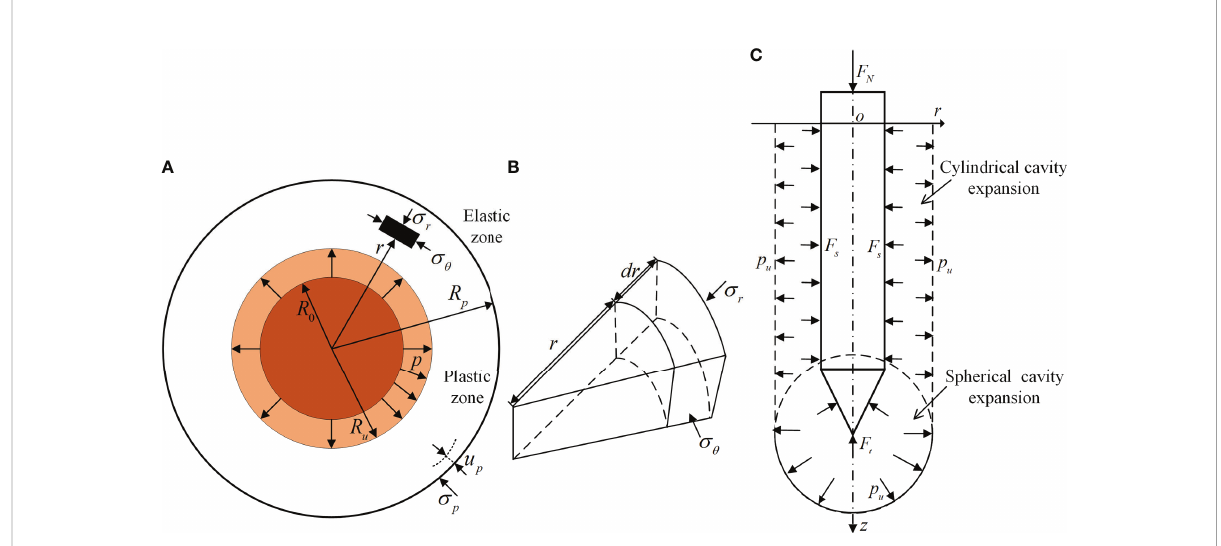
FIGURE 3 (A) Cylindrical cavity expansion model diagram; (B) force analysis of soil elements; and (C) spherical cavity expansion